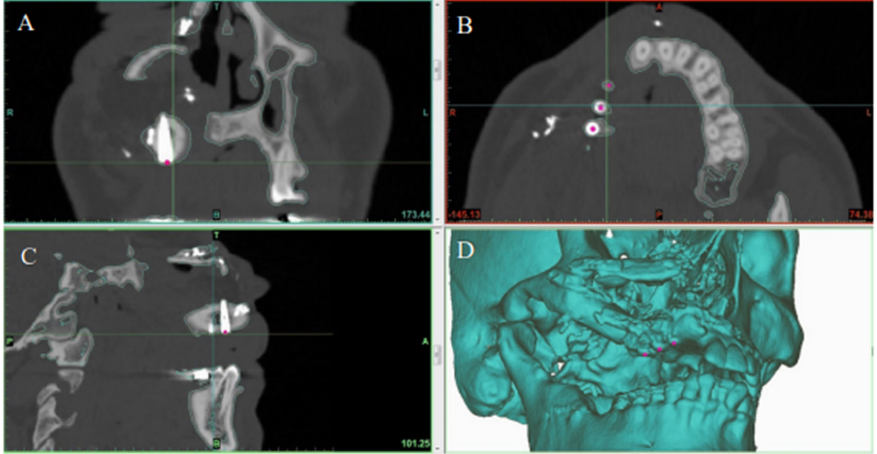
Figure 6. Postoperative CT scan showing the actual position of dental implants in the reconstructed jaw in the ( A ) coronal, ( B ) axial, and ( C ) sagittal planes. ( D ) 3D model showing final jaw reconstruction with implants in their actual position.